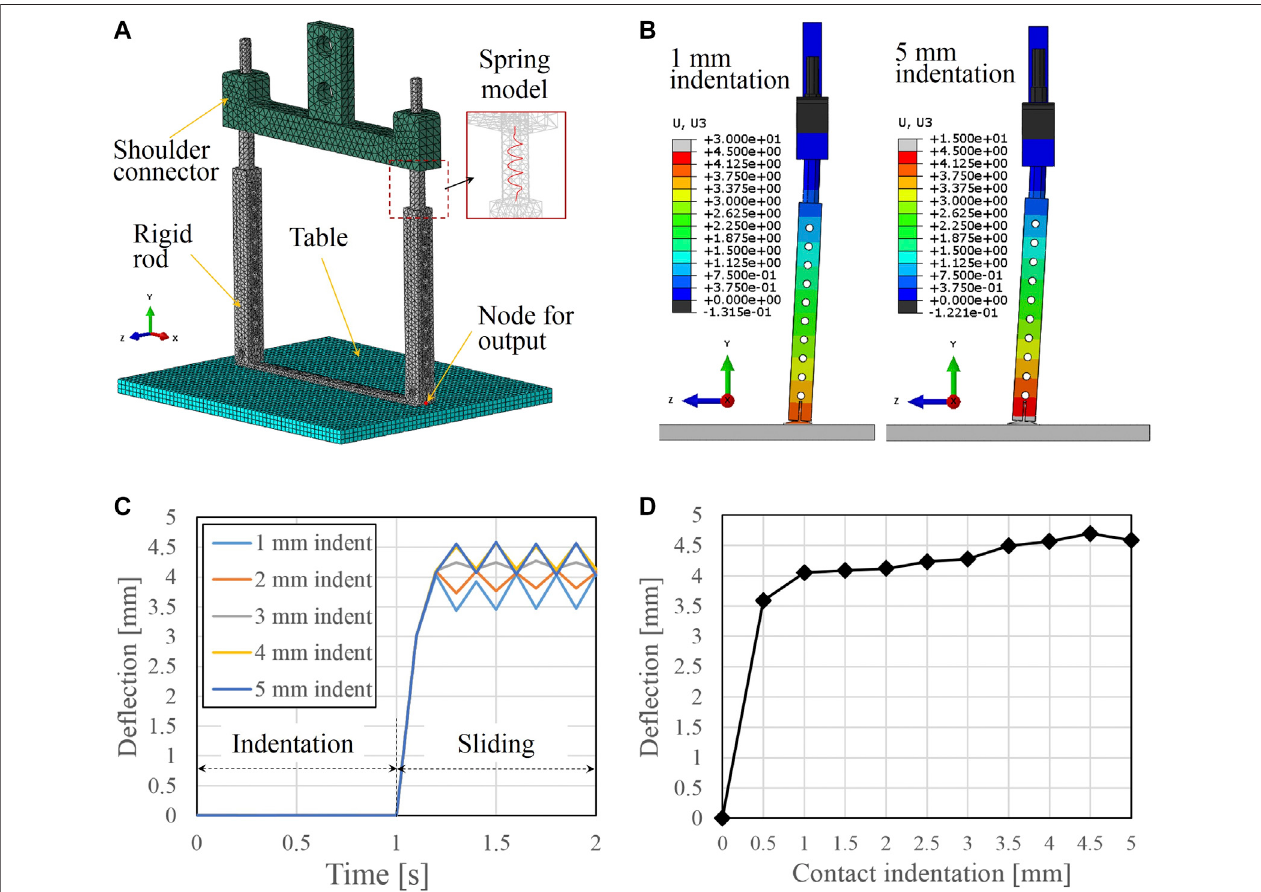
FIGURE4|(A) Finiteelementmodelofthescoop-bindingmechanismcontactingastainlesstable. (B) Examplesofthesimulatedbendingde fl ectionoftherigidrod at indentations of 1 and 5 mm. (C) Simulation results of the bending de fl ection vs. time at different indentations from 1 mm through 5 mm. (D) Comparison of the simulated bending de fl ection at different contact